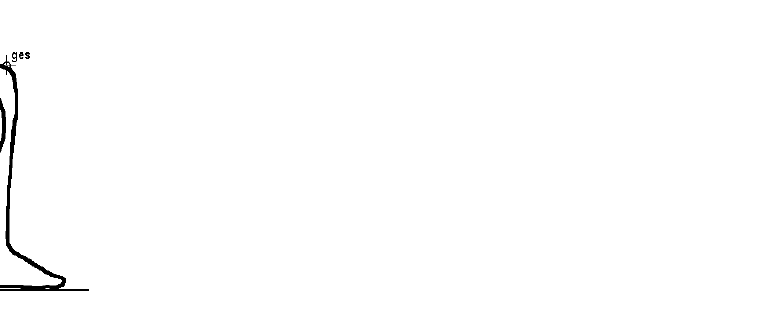
equal to the difference in height of the upper surface of the table and the olecranon point in